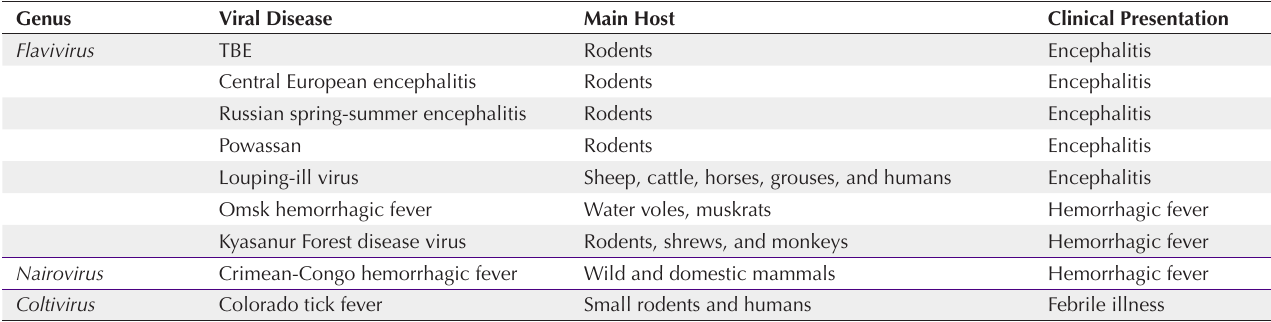
Table 3. Tick-Borne Arbovirus Infections That Cause Human Disease